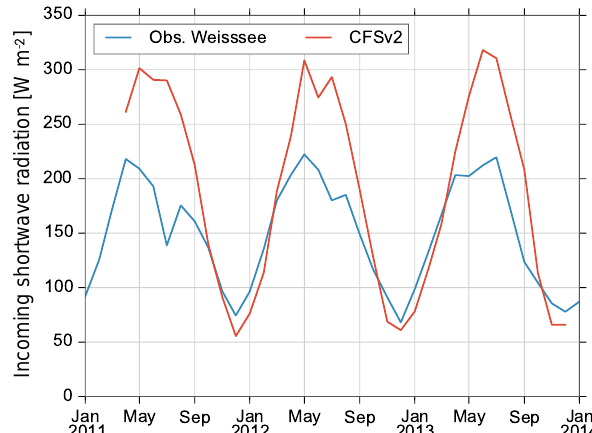
Figure 3. Modelled and observed shortwave radiation. Ob- servations have been recorded at the Weisssee climate station (2480ma.s.l., see Fig. 1), whereas modelled values are derived from CFSv2 without any modification.